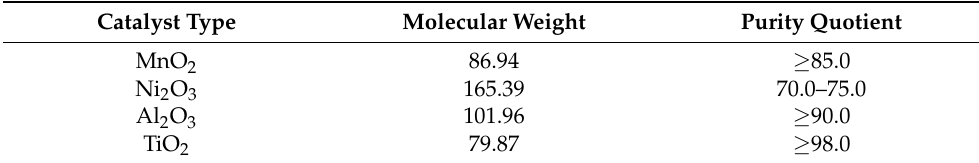
Table 2. List of catalyst